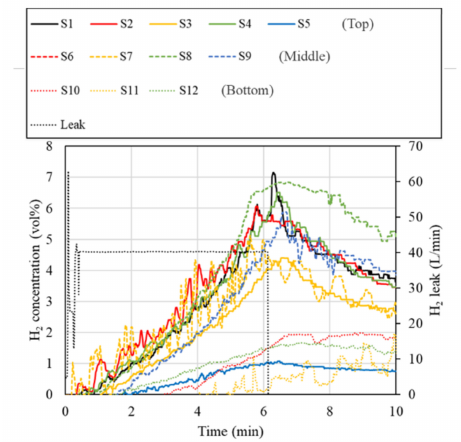
Figure 11. Hydrogen concentration variation by leak (Case 28: hydrogen supply pressure 3 kPa, leak